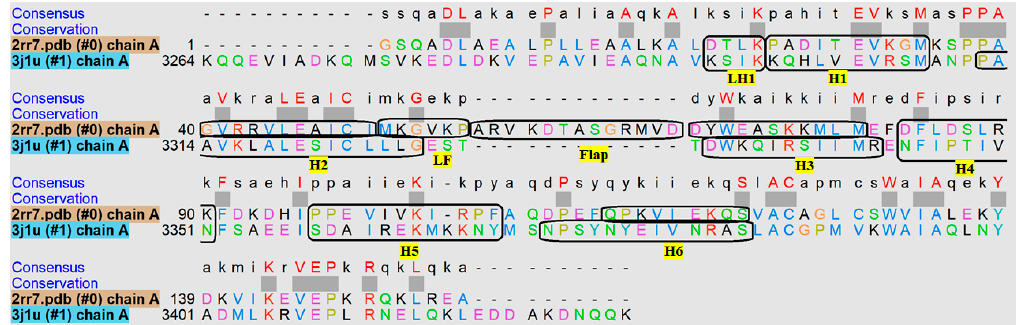
Figure 5. Sequence alignment of axonemal (2rr7.pdb) and cytoplasmic (3j1u.pdb) MTBDs. The six helices are labeled and highlighted in yellow. LH1 and LF stand for the neighboring loop next to H1 and the flap region (The dotted lines and thick grey squares indicate the gap and conserved region between these two proteins amino acid sequence).